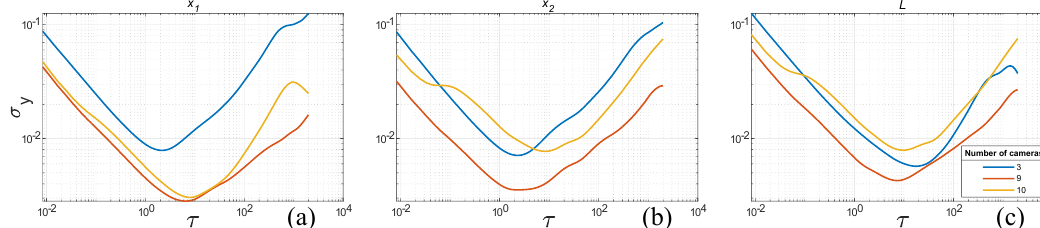
Figure 8. ADEV for Vantage cameras demonstrating the performance loss due to one damaged camera (tenth) for: ( a ) position x 1 , ( b ) position x 2 , ( c ) distance